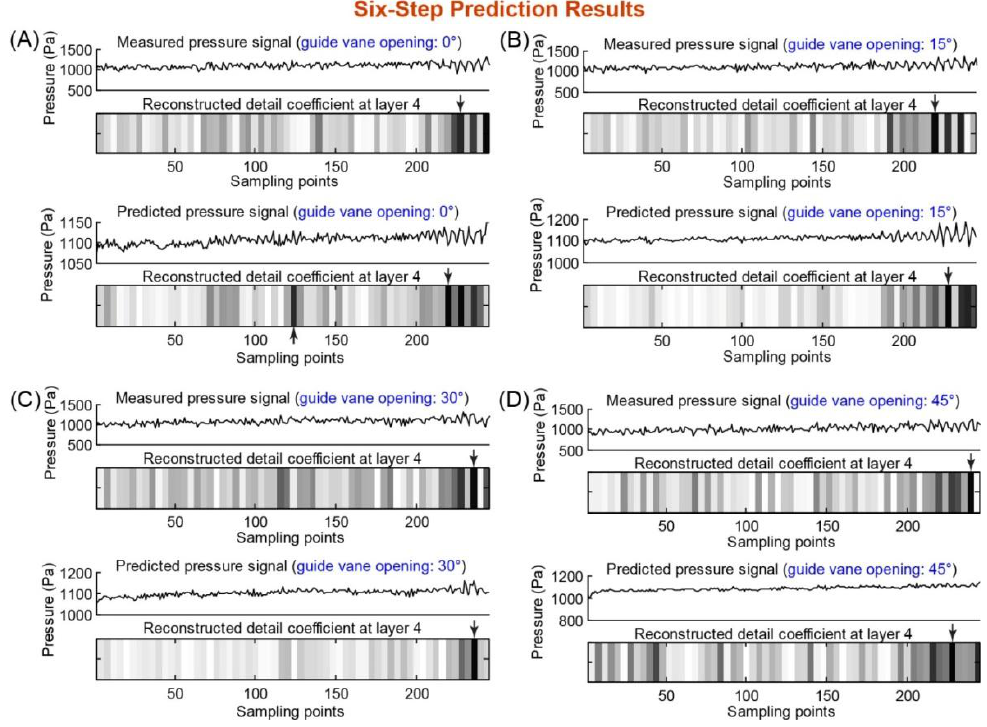
Figure 6. Six-step prediction results of the fan rotation stall at guide vane openings of 0°, 15°, 30° and 45° (panels ( A )–( D )). In each panel (( A )–( D )), the experimental measured pressure signal and its wavelet analysis result ( i.e ., fourth-layer detail coefficient) are shown on the top, and the SVRM-predicted pressure signal and its wavelet analysis result ( i.e ., fourth-layer detail coefficient) are shown on the bottom. The arrows on the fourth-layer detail coefficient plot indicate the starting points of the rotation